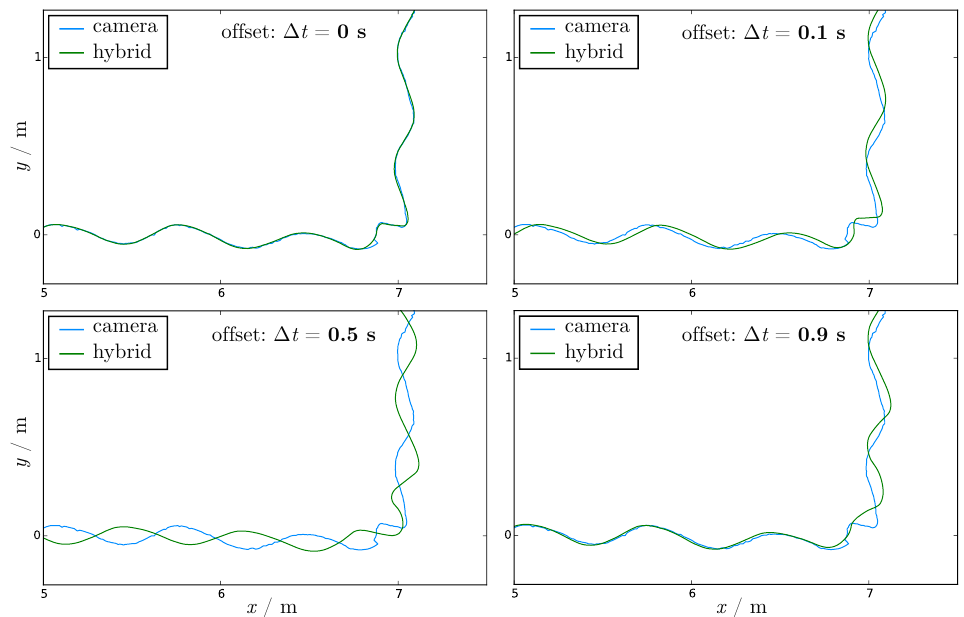
Figure 4. The camera trajectory in blue and the fused trajectory of the HTS in green for the same region as in Figure 3 for given time offset ∆ t values of 0s, 0.1s, 0.5s and 0.9s with regard to the